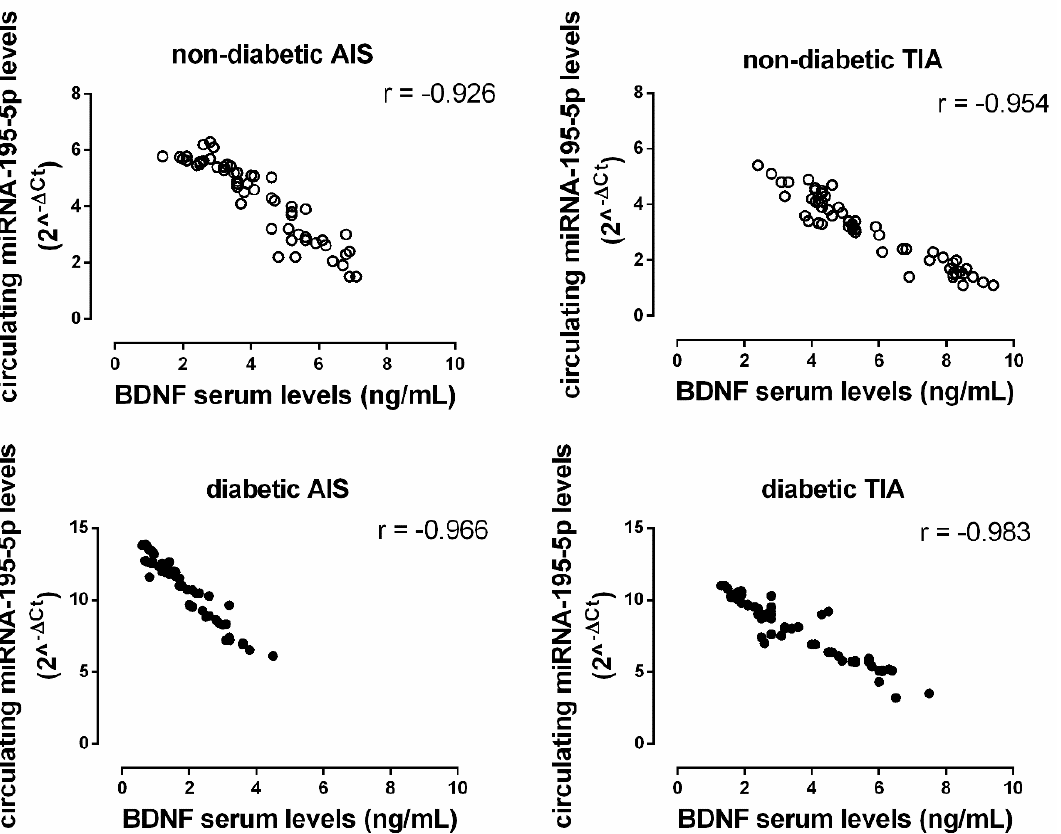
Figure 3. The correlation between miRNA-195-5p expression levels (2 ˆ- ∆ Ct ; y -axis) with the serum levels of brain-derived neurotrophic factor (BDNF; ng / mL; x -axis) in both non-diabetic (ND; empty circle) and diabetic (D; solid black circle) AIS and TIA groups. All correlations are significant at p < 0.05. A significant negative correlation between miRNA-451a levels (2 ˆ- ) and VEGF-A serum levels was observed in the non-diabetic population (AIS: r = − 0.923, p < 0.05; TIA: r = − 0.879, p < 0.05). The same negative correlation was observed in the diabetic population (AIS: r = − 0.936, p < 0.05; TIA: r = − 0.963, p < 0.05) (Figure